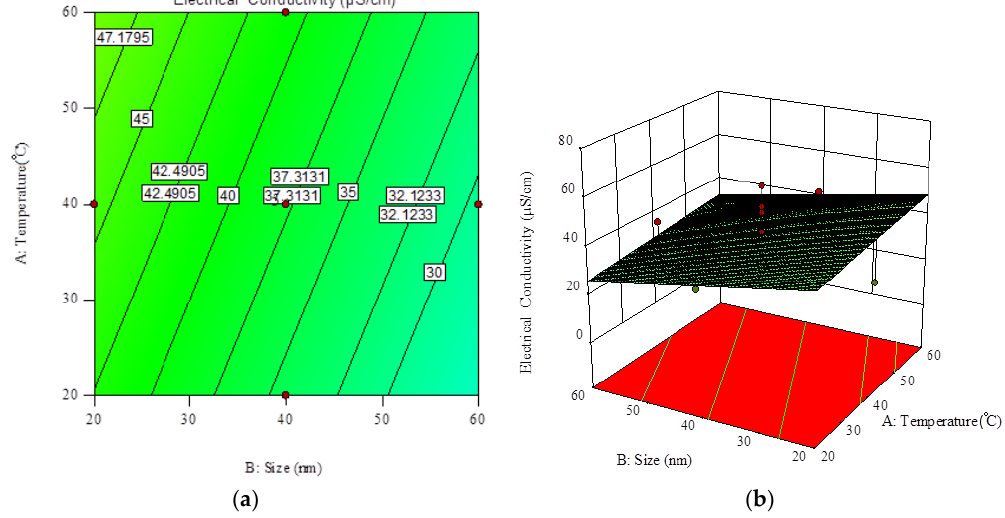
Figure 13. Effect of temperature and nanoparticles size variations on the electrical conductivity of CuO/glycerol nanofluid. ( a ) 2 dimensional; ( b ) 3 dimensional.